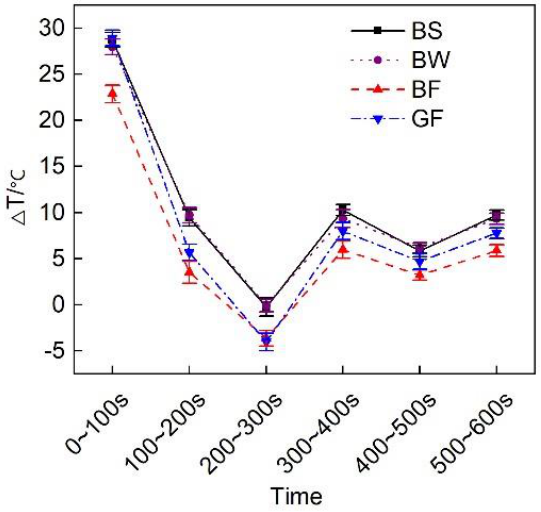
Figure 12. Average temperature drop at each substage of the initial idling stage.